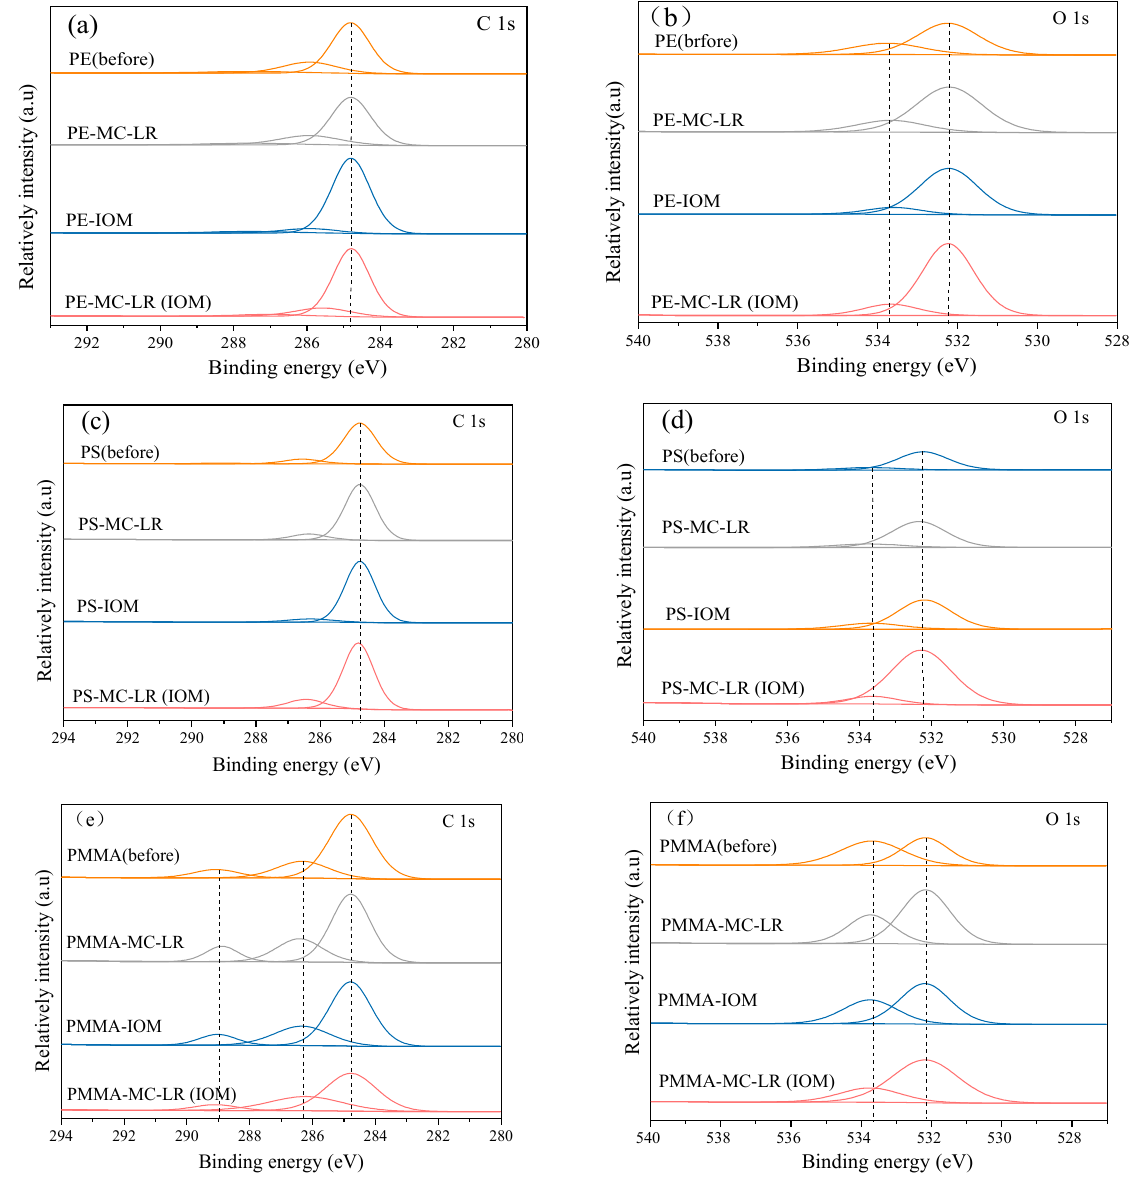
Figure 5. XPS spectra of C, O elements on PE, PS, and PMMA before and after adsorption. C1s ( a ) and O1s ( b ) on PE, C1s ( c ) and O1s ( d ) on PS, C1s ( e ) and O1s ( f ) on PMMA. Table 3. Comparison of the adsorption capability and adsorption mechanism towards organic pollutants of the studied